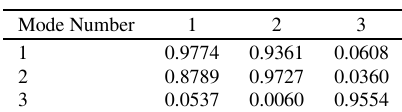
Table 4 Cross MAC values for the periodic chirp (rows)